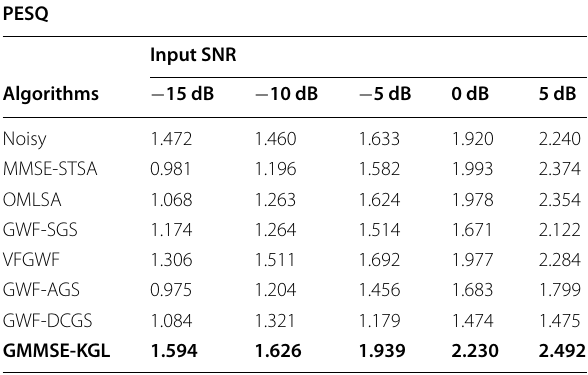
Table 11 The PESQ of different methods for Babble noise PESQ